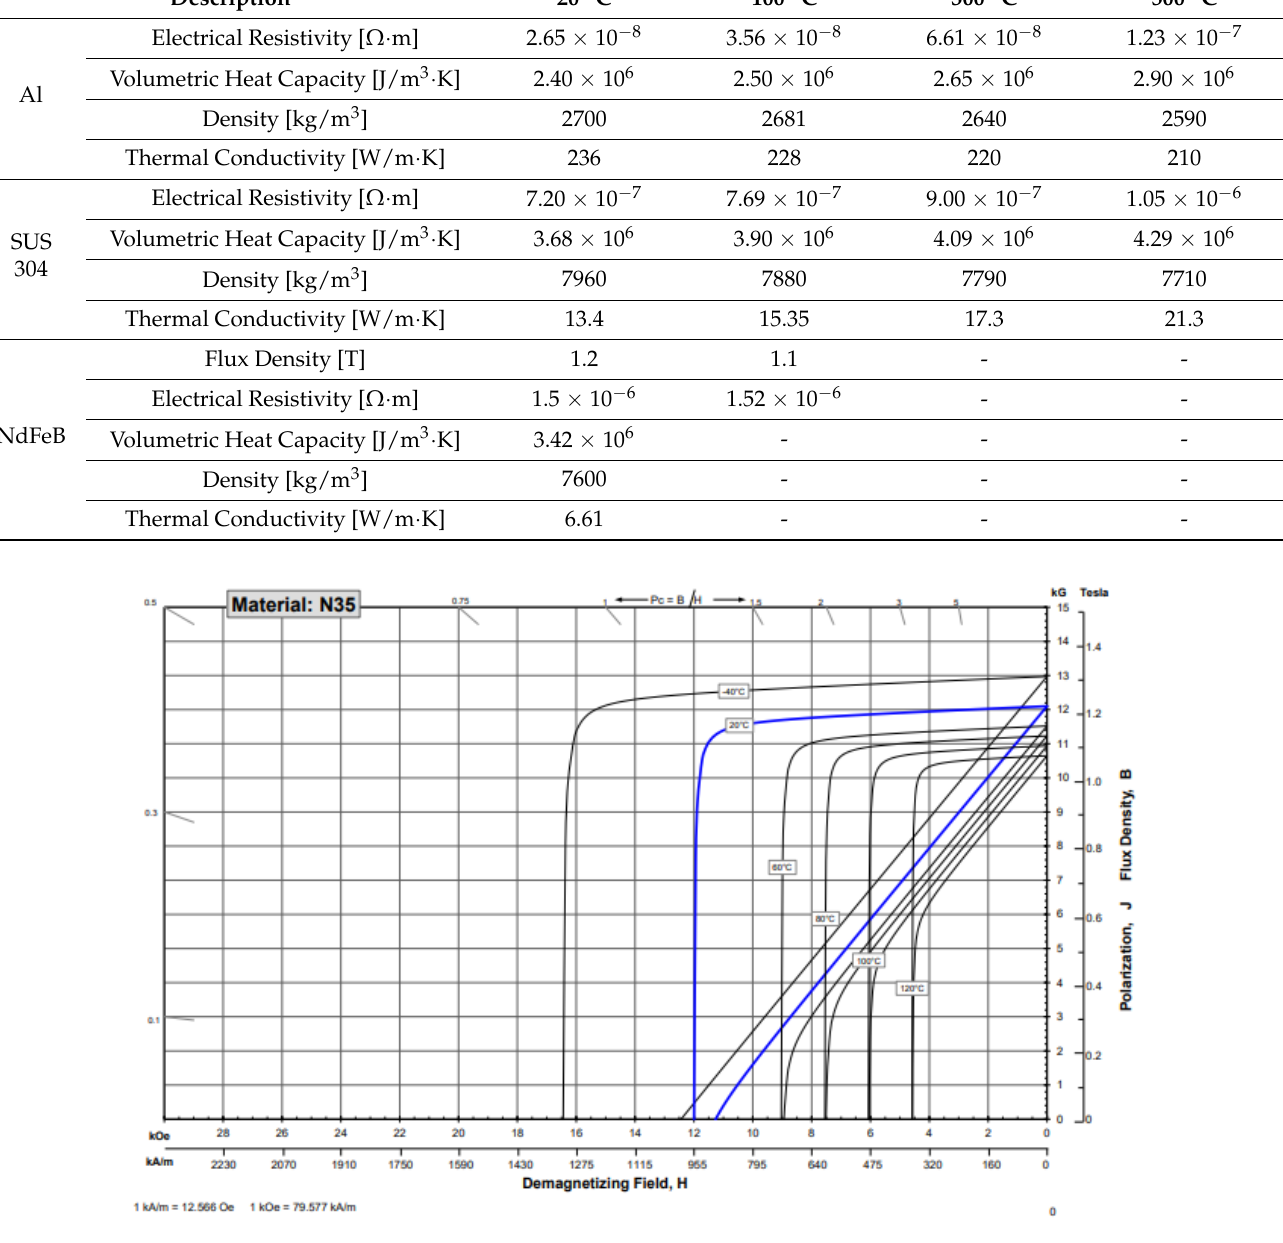
Table 1. Physical properties of billet heating design parts [40,41].